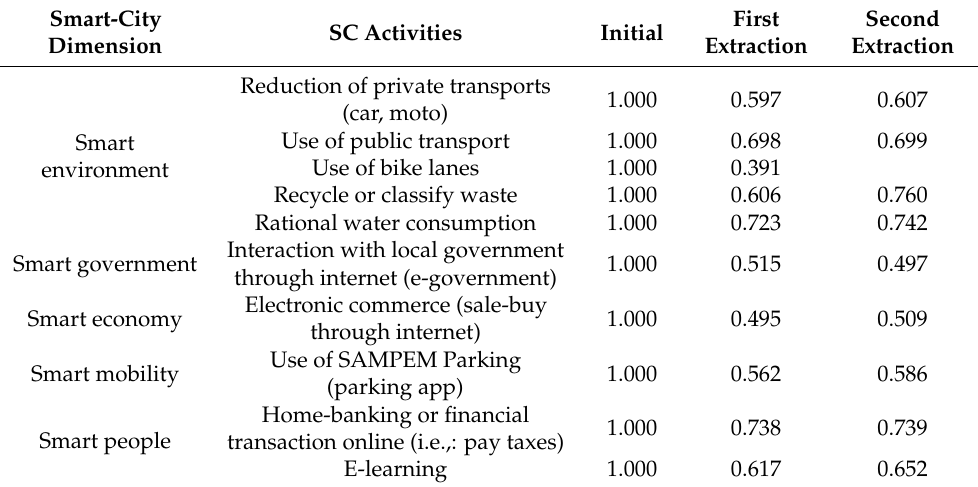
Table 1. Communalities from factor analysis among SC activities. Source: own